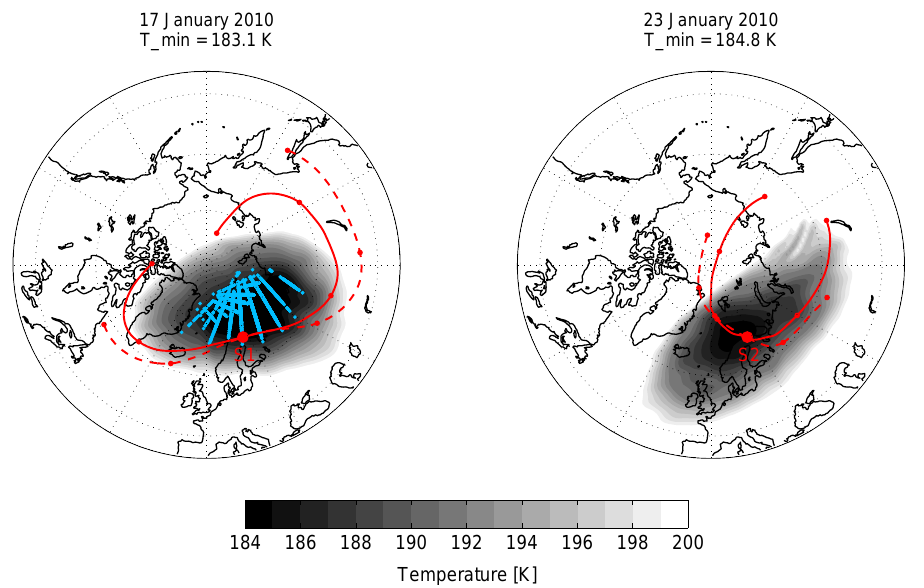
Fig. 1. Polar maps with ERA-Interim temperatures at 30hPa (grayscale) on 17 January 2010 (left) and 23 January 2010 (right). Red curves: CLaMS trajectories starting on these day above Sodankylä at 520K (solid) and 440K (dashed) potential temperature. Trajectories are two days backward and three days forward in time for 17 January 2010 (S1) and three days backward and two days forward in time for 23 January 2010 (S2). Red dots: 24h time periods along the trajectories. Cyan points: ice clouds observed by CALIOP on 17 and 18 January 2010 between 16km and 30km altitude. No ice clouds were observed by CALIOP on 23 January